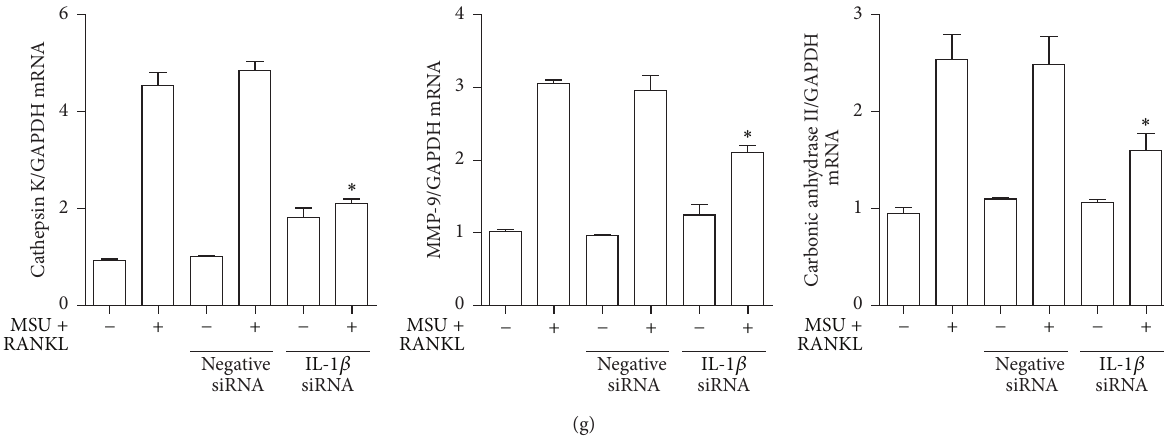
Figure 3: The role of IL-1 𝛽 in osteoclast activation stimulated by MSU crystals. (a) Gene expression of proinflammatory cytokines was measured after stimulation with 0.1 ng/mL of MSU crystals for 24 h. ∗ 𝑝 < 0.01 and # 𝑝 < 0.05 compared to controls. (b) IL-1 𝛽 gene expression in RAW 264.7 cells alone (controls) and cells incubated with MSU crystals alone (0.1mg/mL), RANKL alone (100 ng/mL), or both for 24 h. ∗ 𝑝 < 0.05 , # 𝑝 < 0.01 , and † 𝑝 < 0.01 . (c) IL-1 𝛽 mRNA expression was assessed in RAW 264.7 cells alone (controls) and cells transfected with negative and IL-1 𝛽 siRNA at different dosages (0, 30, 50, and 100ng/mL) and incubation times (24, 48, and 72 h) in the presence or absence of both MSU crystals (0.1mg/mL) and RANKL (100ng/mL). ∗ 𝑝 < 0.05 and # 𝑝 < 0.01 compared to cells transfected with 0 ng/mL of IL-1 𝛽 siRNA. (d) TRAP and actin ring staining were performed in control RAW 264.7 cells and IL-1 𝛽 siRNA (50 ng/mL) transfected cells under stimulation with both MSU crystals (0.1mg/mL) and RANKL (100ng/mL) for 10 days. ∗ 𝑝 < 0.05 compared to control cells treated with both MSU crystals and RANKL. (e) RANKL and RANK gene expression were measured in controls and negative and IL-1 𝛽 siRNA transfected cells under stimulation with both MSU crystals (0.1mg/mL) and RANKL (100ng/mL) for 24 h. ∗ 𝑝 > 0.05 , # 𝑝 < 0.01 , and † 𝑝 > 0.05 . (f) Cleaved IL-1 𝛽 , TRAF-6, phospho-JNK, phospho-c-Jun, and NFATc1 protein levels were measured in RAW 264.7 cells transfected with negative siRNA and IL-1 𝛽 siRNA (50 ng/mL) for 72 h. (g) The mRNA expression of osteoclast-specific genes was measured in controls and negative and IL-1 𝛽 siRNA (50 ng/mL) RAW 264.7 cells. ∗ 𝑝 < 0.05 compared to cells treated with both MSU crystals and RANKL.